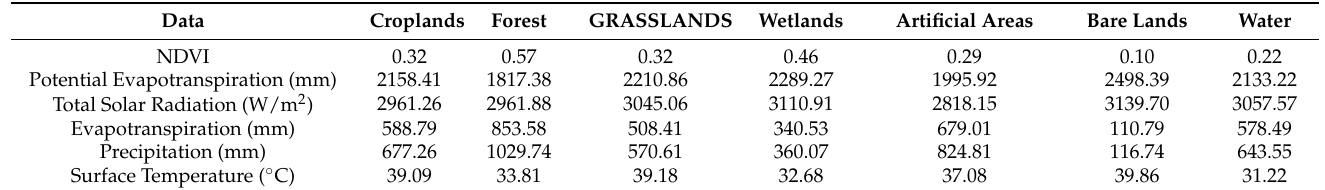
Table 5. Annual average various data statistics of different land cover types in the CLCB between 2001 to 2020.